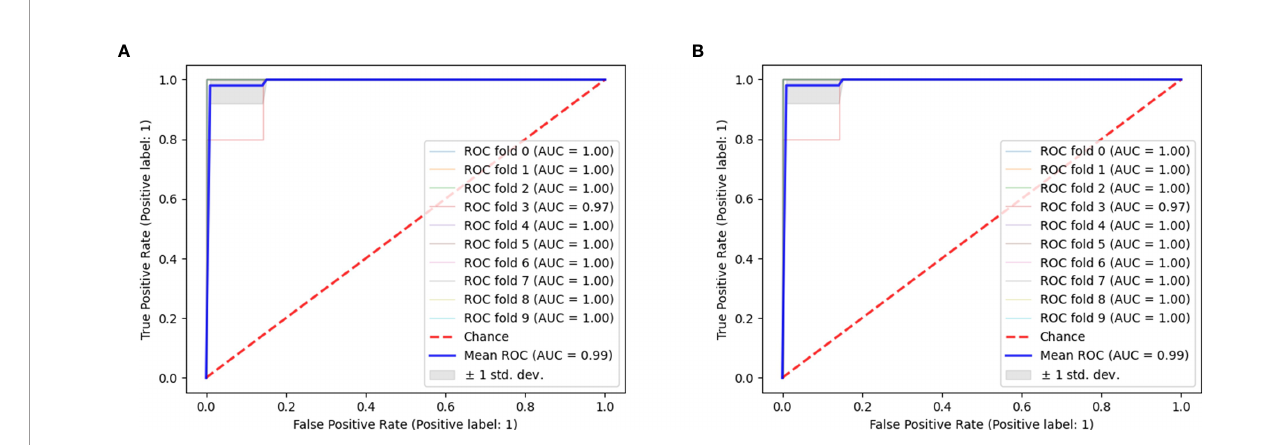
FIGURE 6 | The ROC curves of 10 fold for DC+RF (A) and Xgboost+RF (B) in the